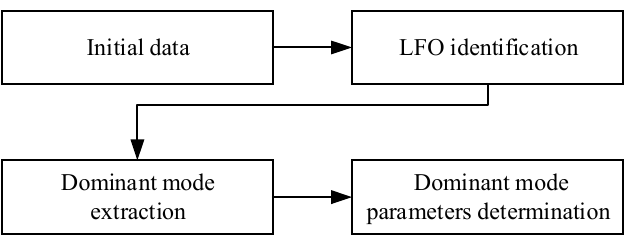
Figure 1. Flow chart for estimating LFO for power system operation parameters.